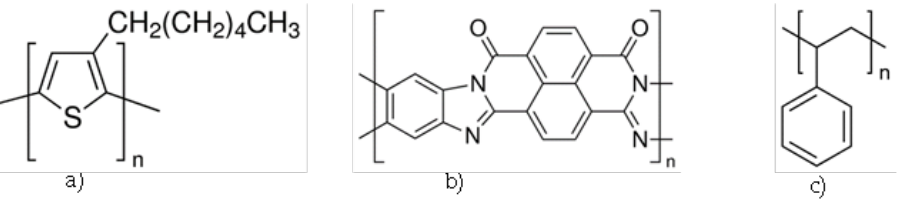
Figure 1. Coaxial nanofiber was fabricated by using P3HT ( a ) and BBL ( b ) as the semiconducting polymers. Because pure P3HT is unable to form fibers (due to its low molecular weight), PS ( c ) was added to improve mechanical support for fiber formation.